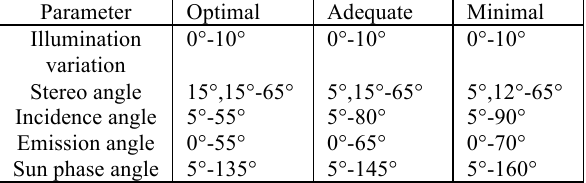
Table 1: Optimal, adequate and minimal parameter ranges for key stereo observing attributes.